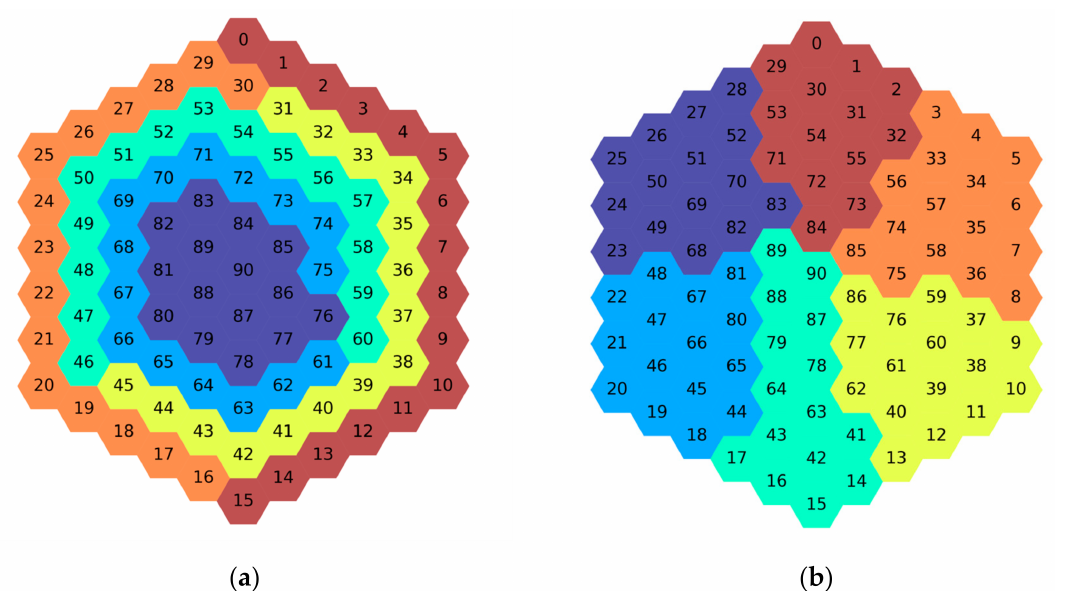
Figure 6. ( a ) Core of benchmark; ( b ) grid elements and assembly.